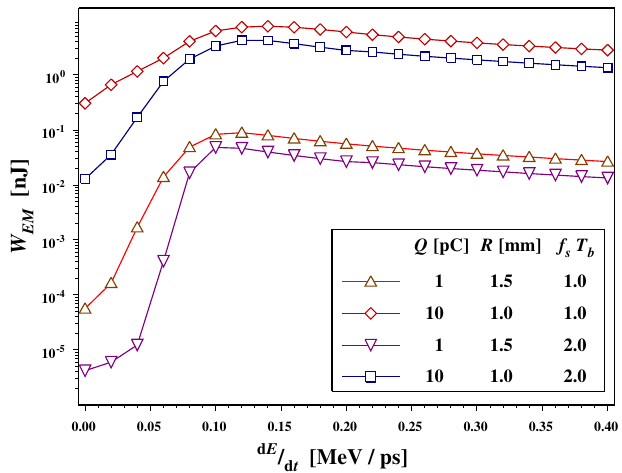
FIG. 7. (Color) The total emitted energy flux as function of =dt energy chirp rate dE k